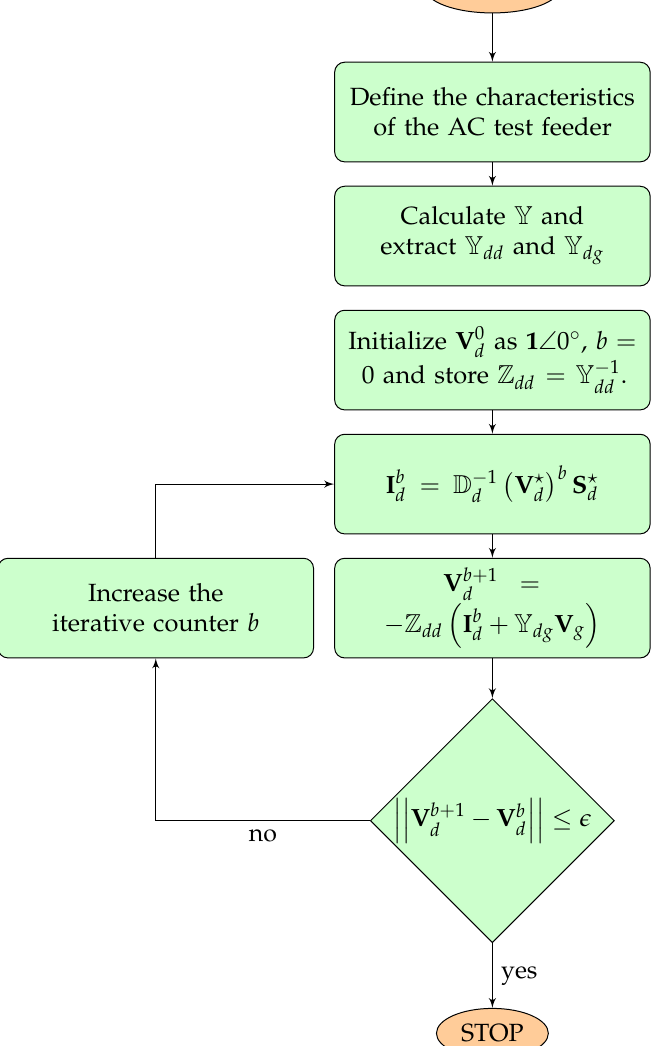
Figure 1. Flowchart of the successive approximation power flow method used in the slave stage of the proposed discrete version of the vortex search algorithm